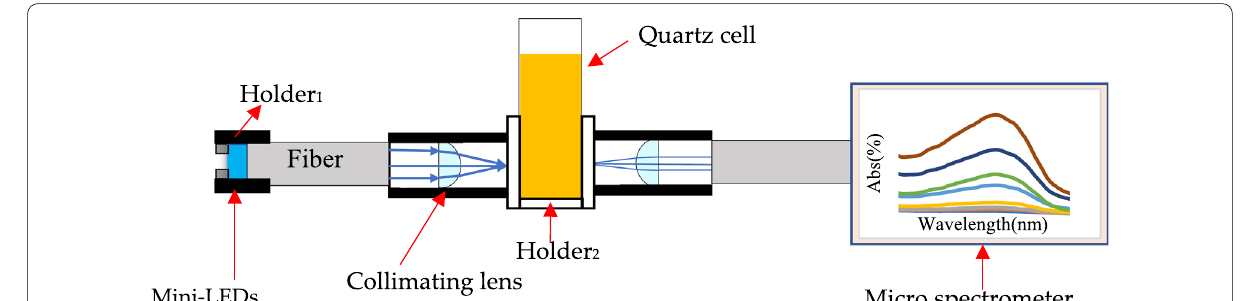
Fig. 2 Mini‑LEDs MOD optomechanical